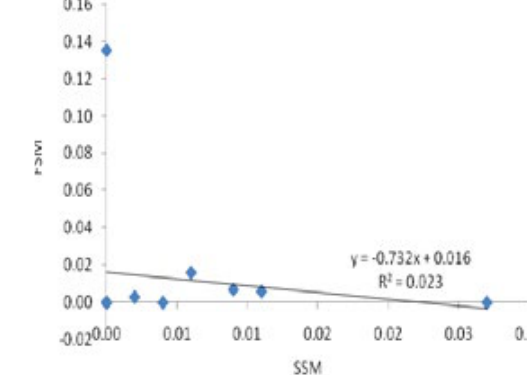
Fig. 3: Correlation between OC levelsin FS